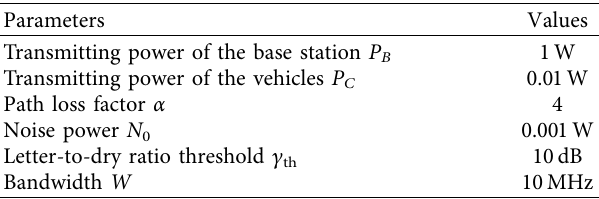
Table 3: Experimental parameter